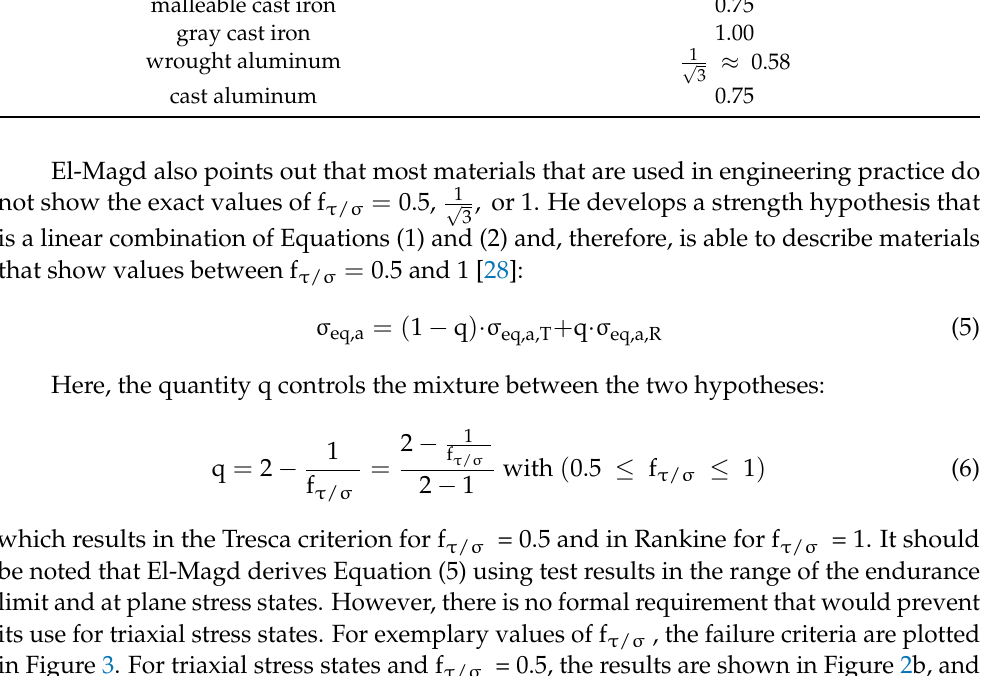
Table 1. General values for the ratio of endurance limits for shear and normal stresses according to FKM guideline [5].